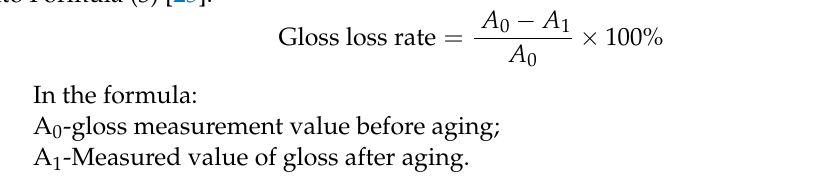
surface of the heat-reflective coating aged faster than the